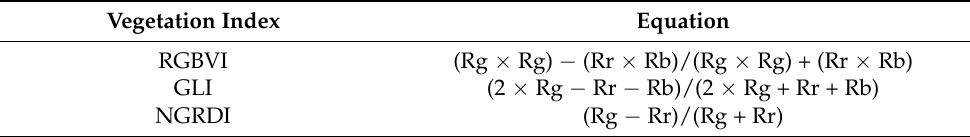
Table 3. Vegetation indexes equations. Rr = red, Rg = green, and Rb = blue. Vegetation